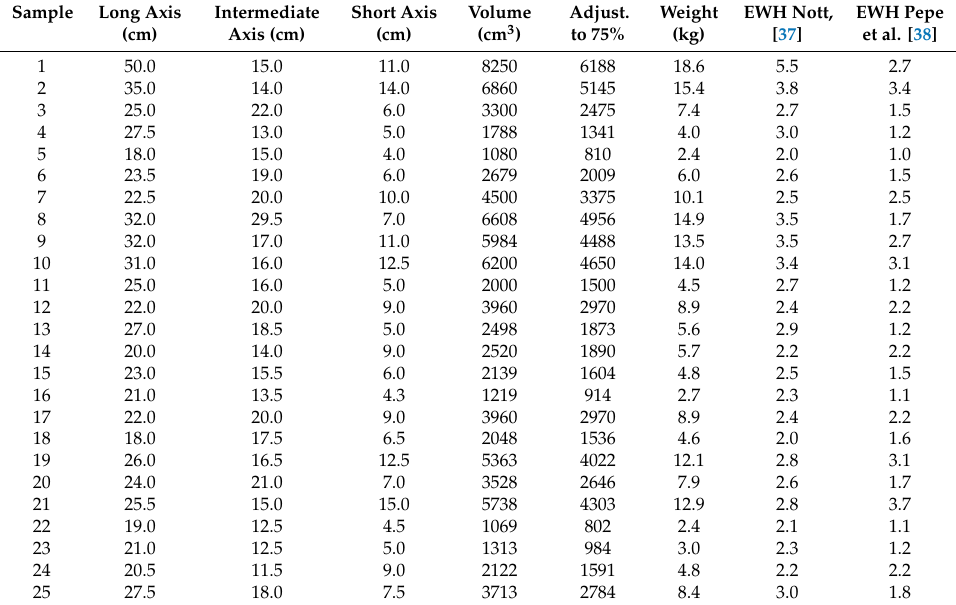
Table 3. Quantification of boulder size, volume, and estimated weight from the modern coastal boulder deposit at site 3 at Ponta do Castelo, from the southeast end of Santa Maria Island (see map, Figure 1b). The standard density of basalt at 3.0 gm / cm 3 was applied uniformly in order to calculate wave height for each boulder. EWH: estimated wave height (in meters), calculated from equations in Nott [37] and Pepe et al. [38]. See the methods Section 3.2. (hydraulic model).